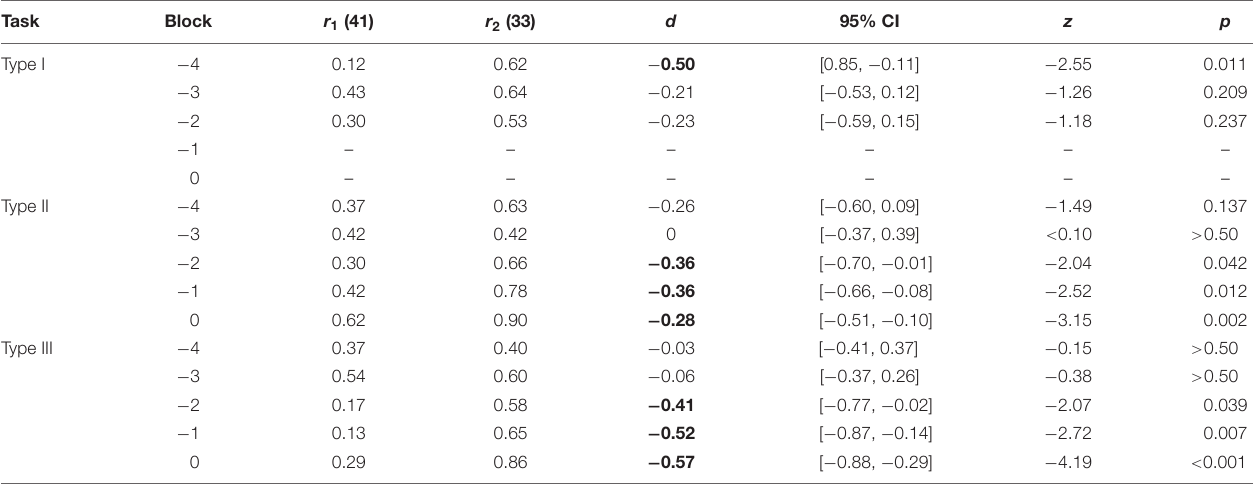
TABLE 3 | Differences between the accuracy-judgment correlations observed in Experiment 1 and 2 across learning